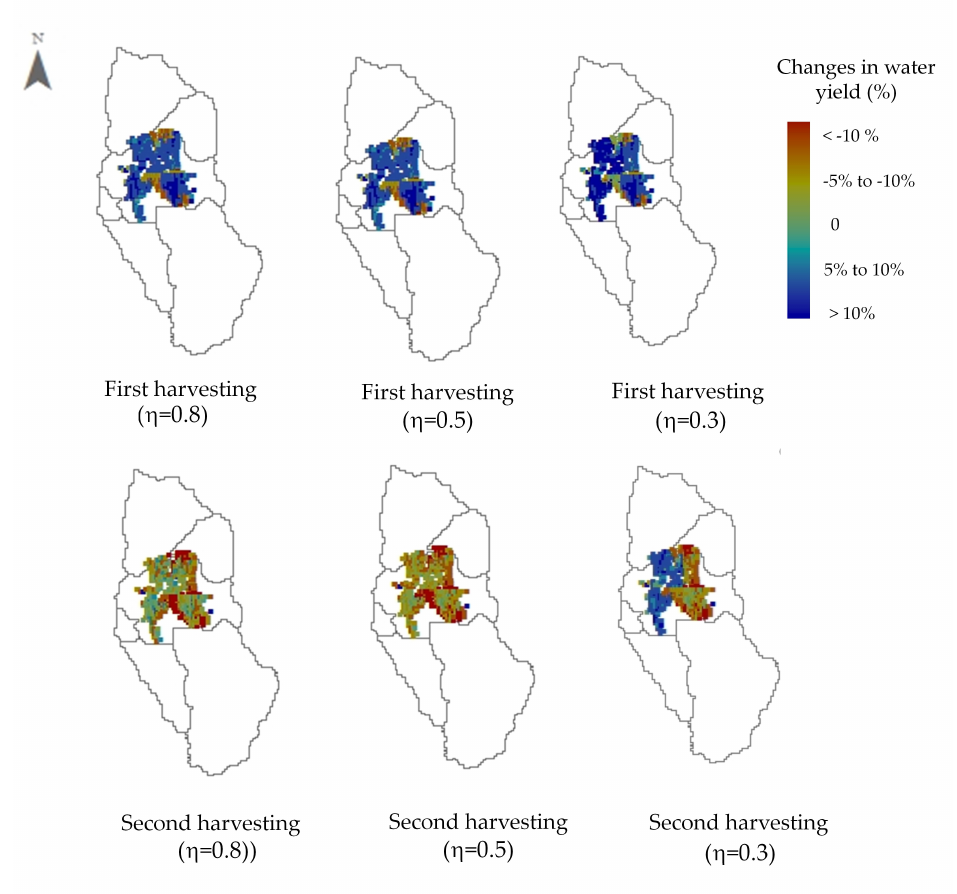
Figure 8. Expected changes in water yield for the first and second harvesting cycle (Results for the water maximization scenario (W), a discount rate 4%, and a maximum harvesting rates( η ) of 0.3, 0.5 and